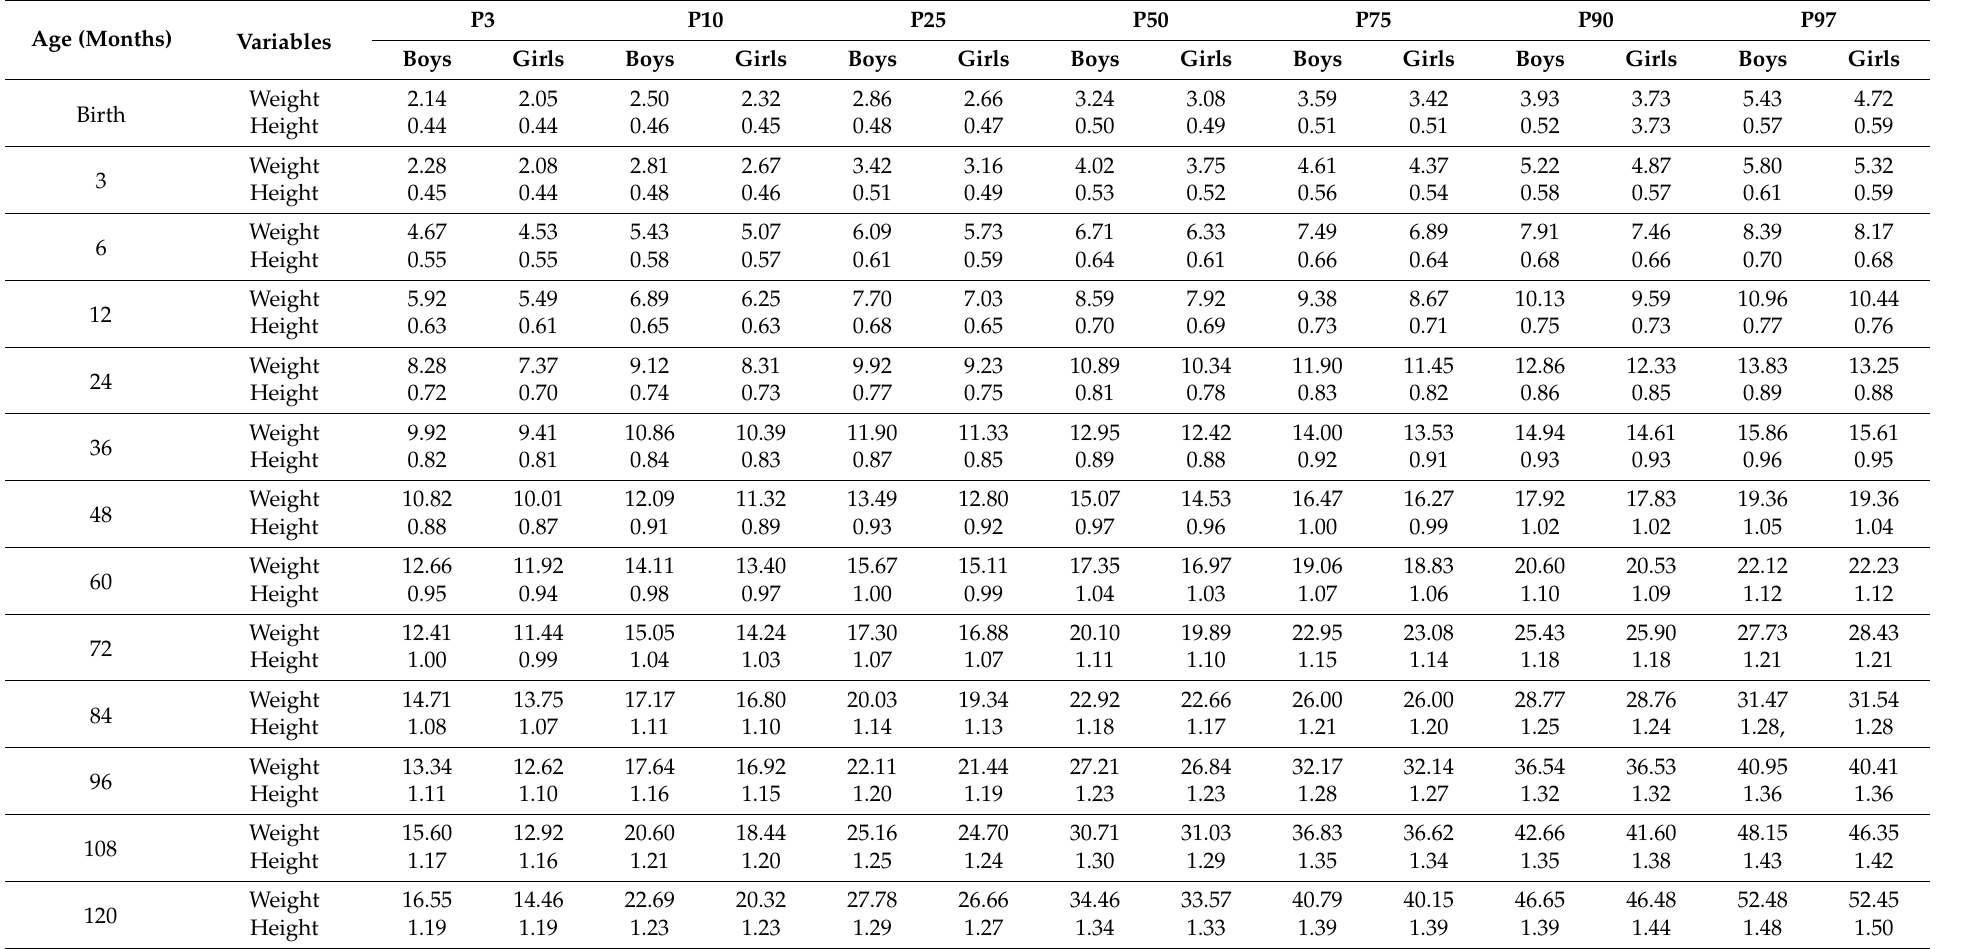
Table 6. Weight and height percentiles in boys and girls according to